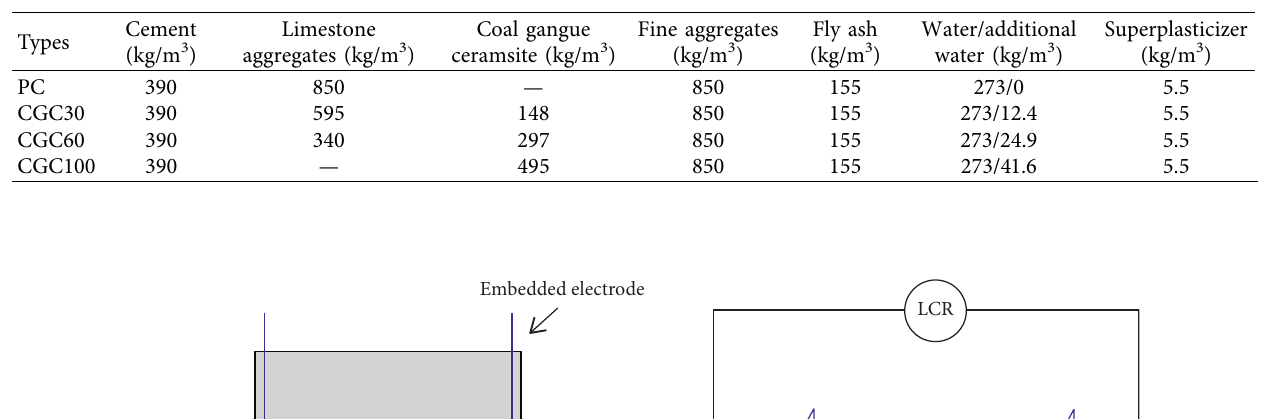
Table 2: Mix proportion of the concrete.